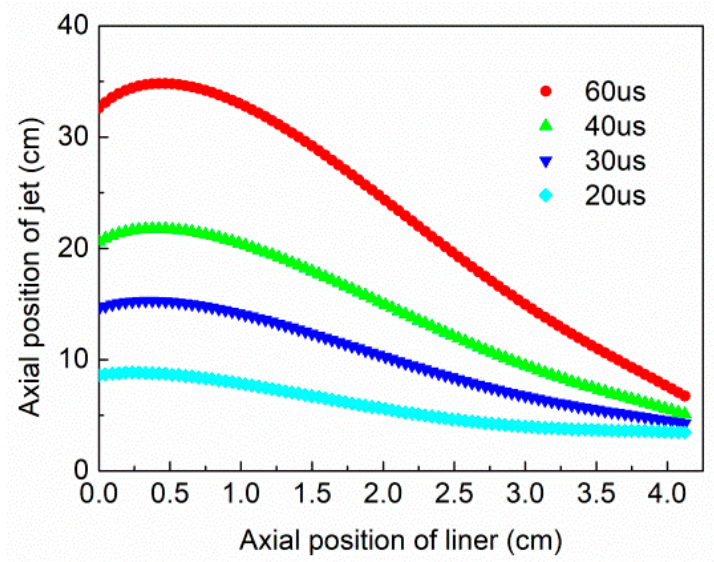
Figure 6. Tensile motion of the jet.